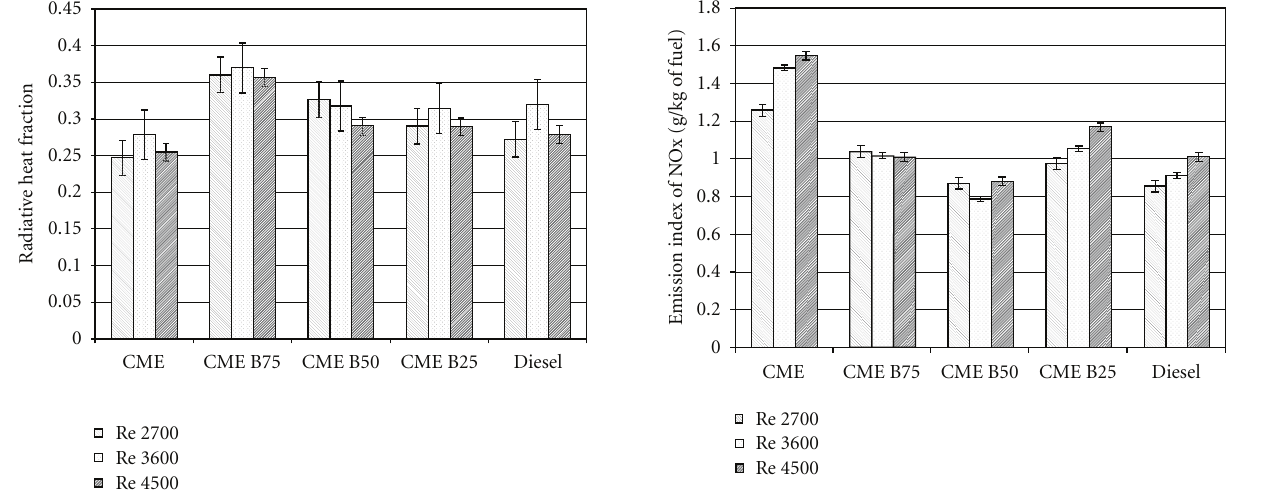
(2303 K for pure diesel, 2300 K for CME B25, 2297 K for CME B50, 2294 K for CME B75, and 2291 K for CME). The